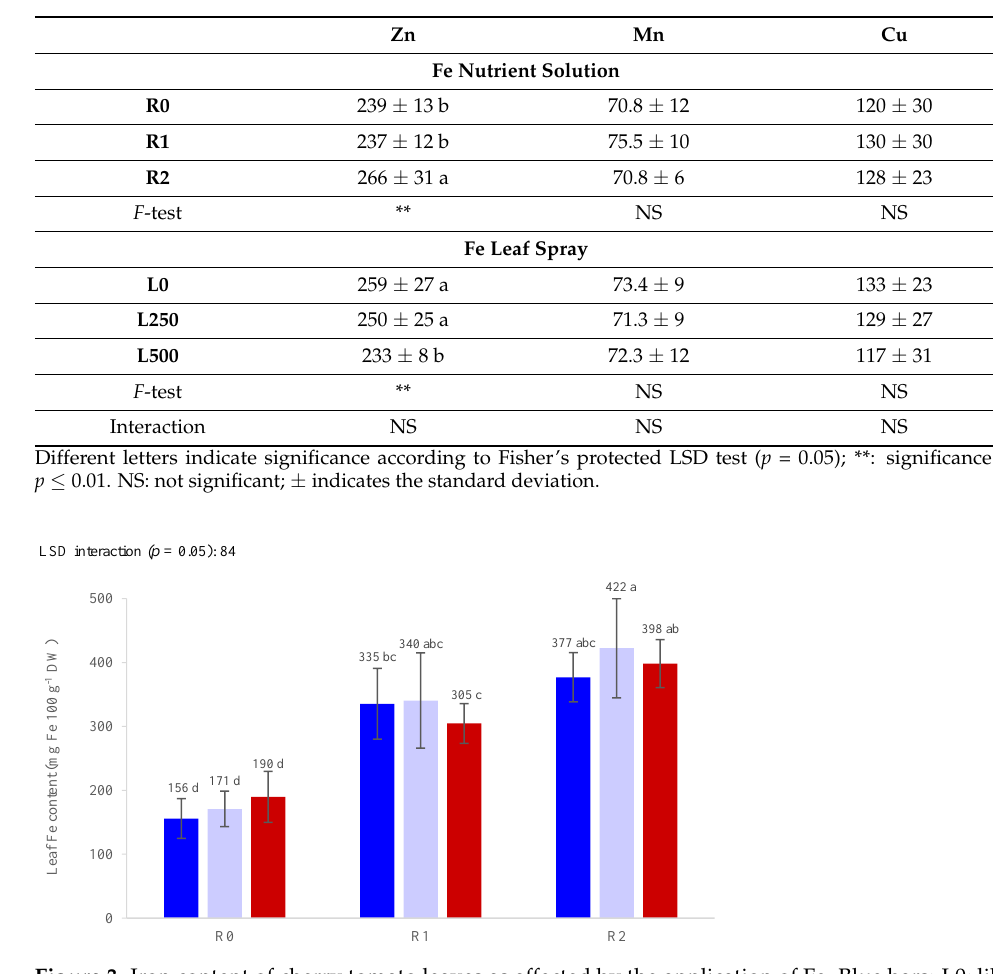
Figure 3. Iron content of cherry tomato leaves as affected by the application of Fe. Blue bars: L0; lilac bars: L250; red bars: L500. Different letters indicate significance according to Fisher’s protected LSD test ( p = 0.05). Error bars indicate the standard deviation.